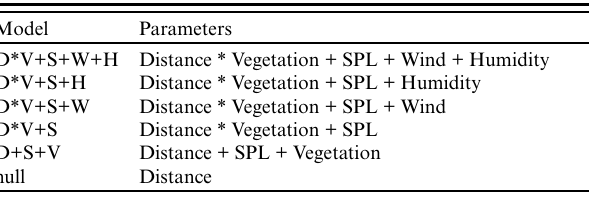
Table 2 . Candidate models to be compared against a null distance model for the SPL experiment.